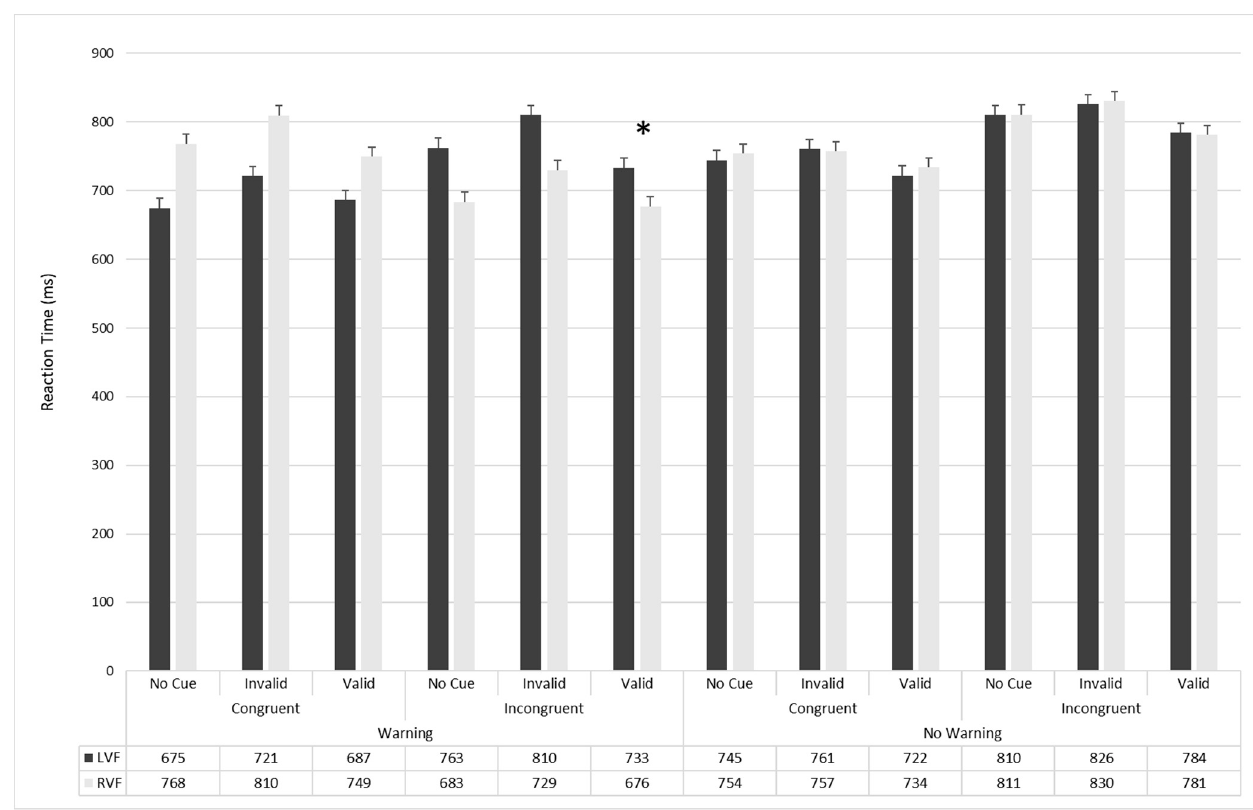
Figure 2. Main reaction times (in milliseconds) for each condition of the LANTI-F, separately for the LVF and the RVF. * : p < 0.05.